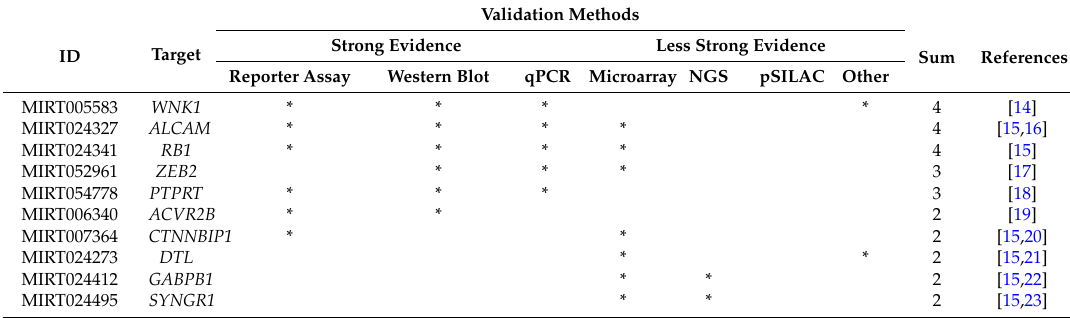
Table 2. Top 10 of the predicted target genes for miR-215 that identified by MiRTarBase.